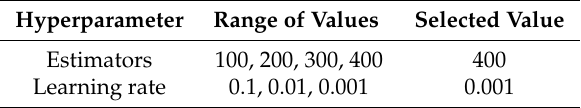
Table 2. Adaboost hyperparameter selected through